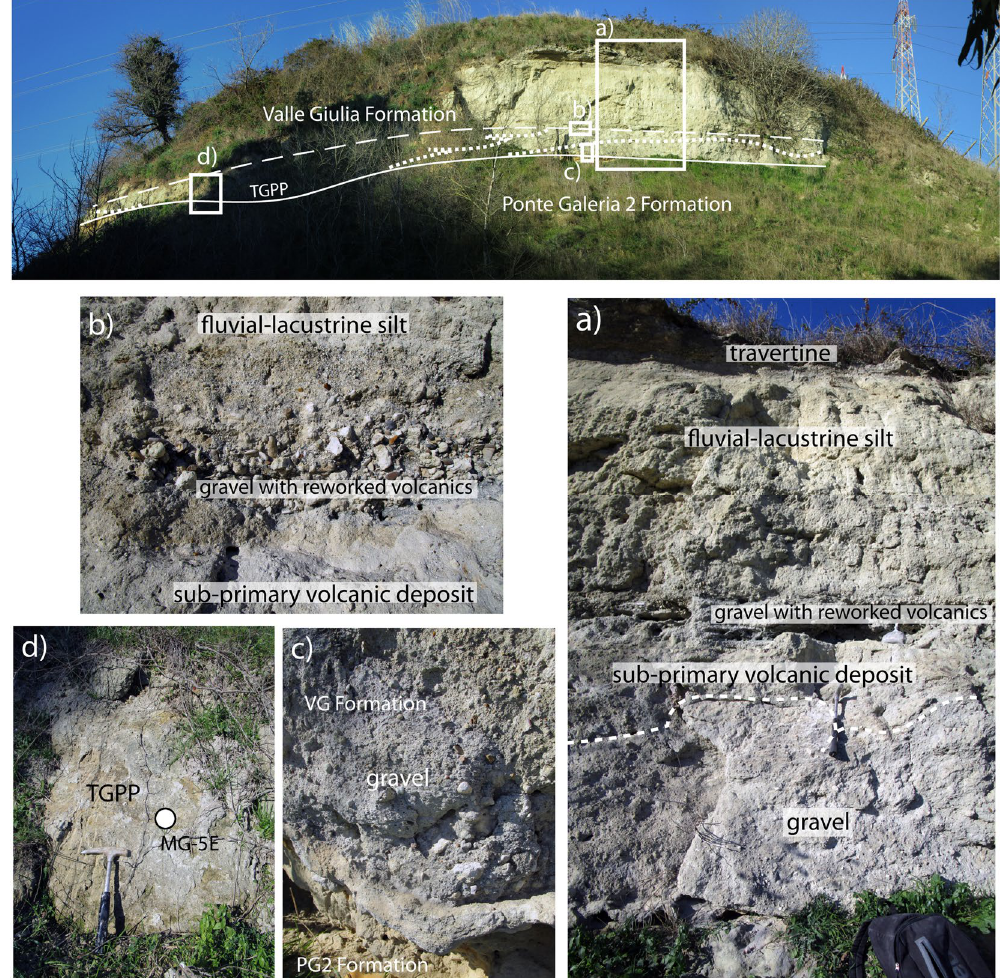
Figure 4. A) Malagrotta section exposing the sedimentary deposit of the Valle Giulia Formation (MIS 13), erosionally above those of the older Ponte Galeria 2 Formation (MIS 17). A massive, sand matrix supported gravel layer ( a , c ) is present at the base of the incision hosting the aggradational succession of the Valle Giulia Formation (MIS 13), which cut through the sand deposit of the Ponte Galeria 2 Formation (MIS 17). The gravel is laterally in contact with both the primary deposit of the TGPP ( d ), as well as with abundant, sub-primary volcanic deposit ( a , b ), providing further evidence that the pyroclastic-flow deposit was emplaced during an erosive phase. See text for further